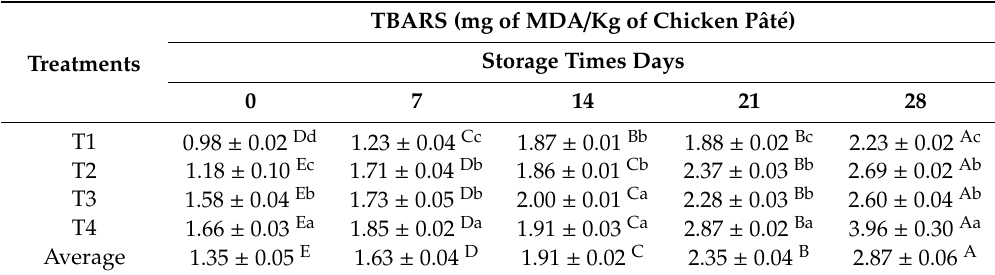
Table 4. Average values of TBARS in poultry p â t é with rosemary and sage extract during storage at 4 ◦ C. Treatments